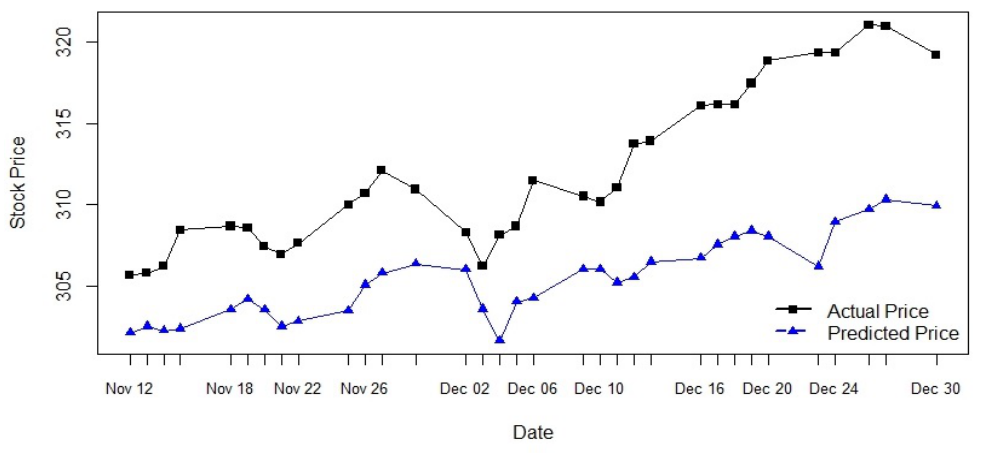
Figure 10. ANN(7-15-1) prediction.